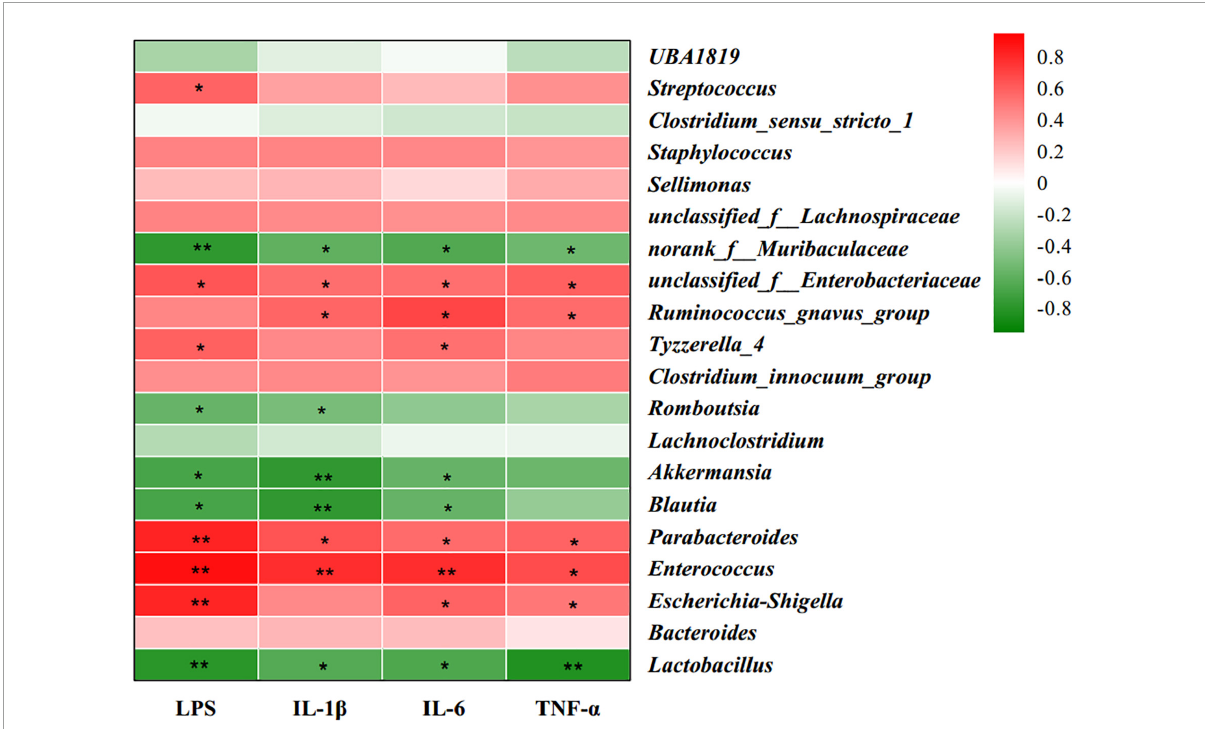
FIGURE5 Heatmap of Spearman’s correlation between gut microbiota (the 30 most abundant species at the genus level) and serum inflammatory factors. Red color represents a positive correlation, while green color represents a negative correlation. n = 6. *0.01 < P ≤ 0.05, **0.001 < P ≤